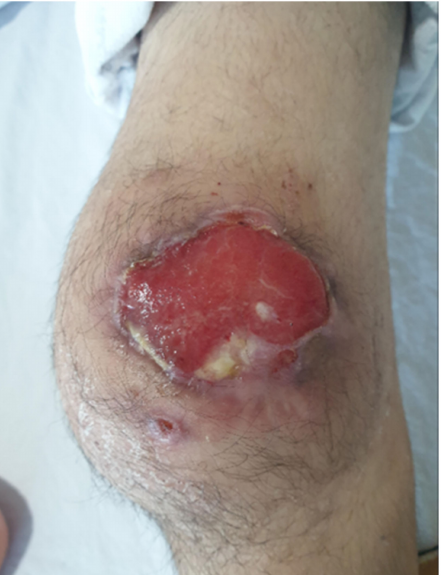
Figure 3. Skin breakage with concurrent serous discharge appeared in the prepatellar area 4 weeks after the onset of initial